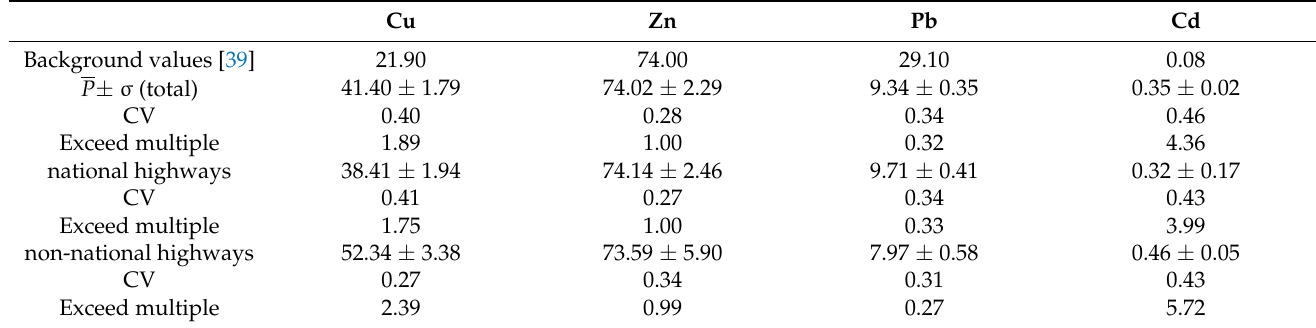
Table 4. Descriptive statistics of soil heavy metal concentrations (mg · kg − 1